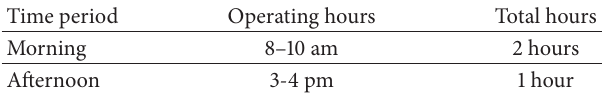
Table 10: Average illuminance (lux) in the class rooms at different times of the day.